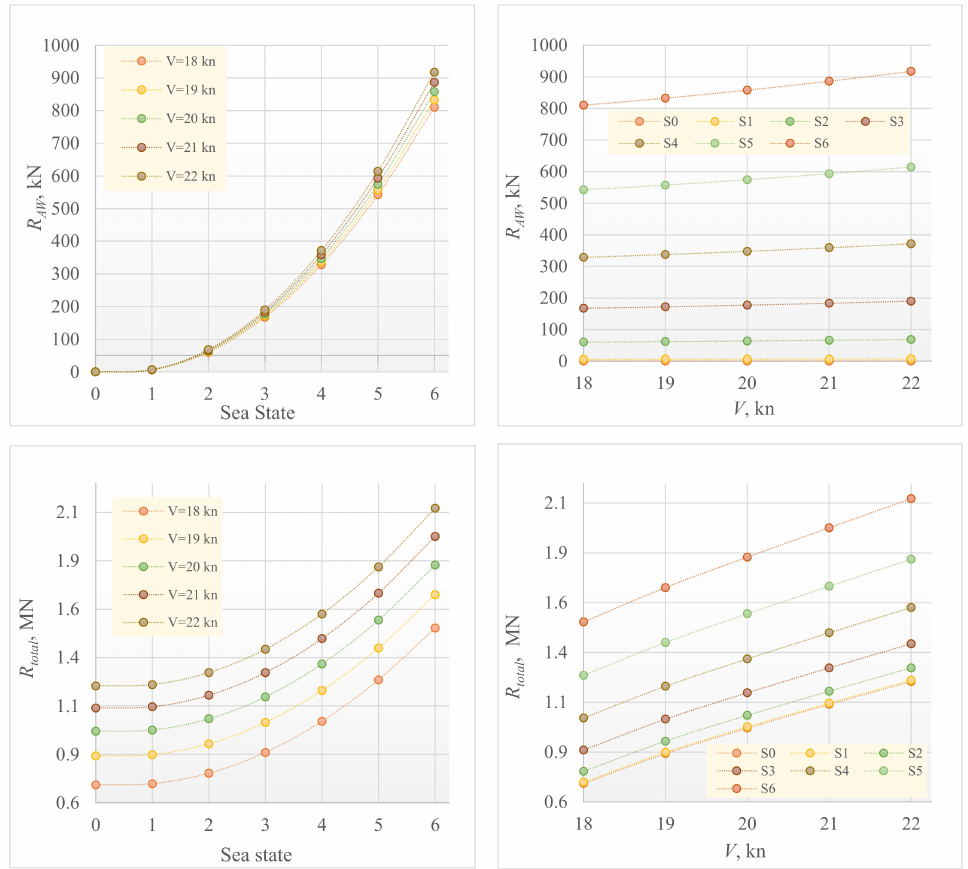
Figure 3. Added resistance in waves for various sea states ( upper left ) and sailing speeds ( upper right ) and total resistance in waves for various sea states ( lower left ) and sailing speeds ( lower right